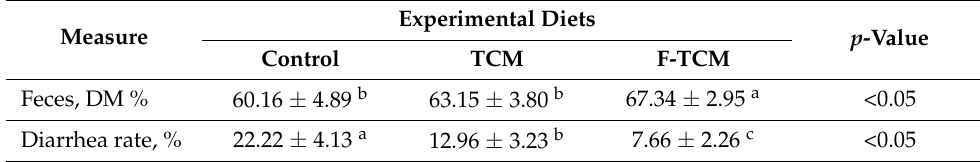
Table 5. The DM of feces and the diarrhea rate of weaned piglets (mean ±